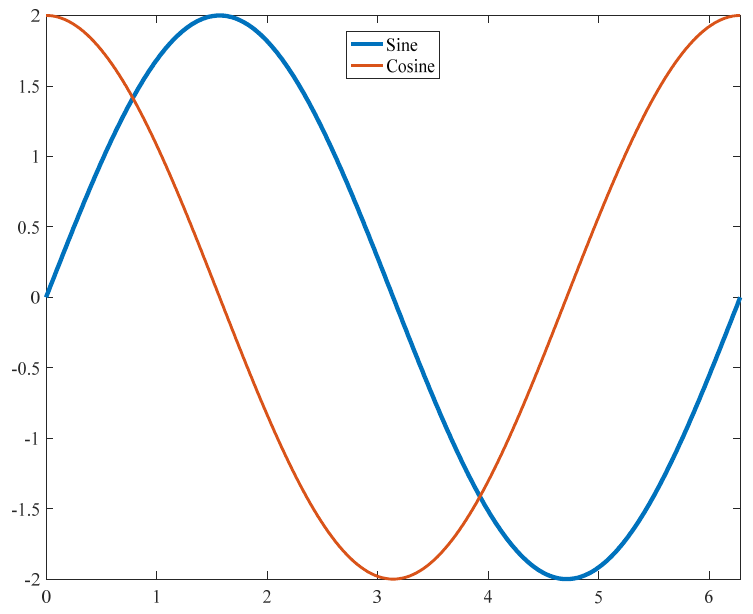
Figure 8. Amplitude scale of ( − 2, 2) and a period range of (0, 2 π ) for sine and cosine.